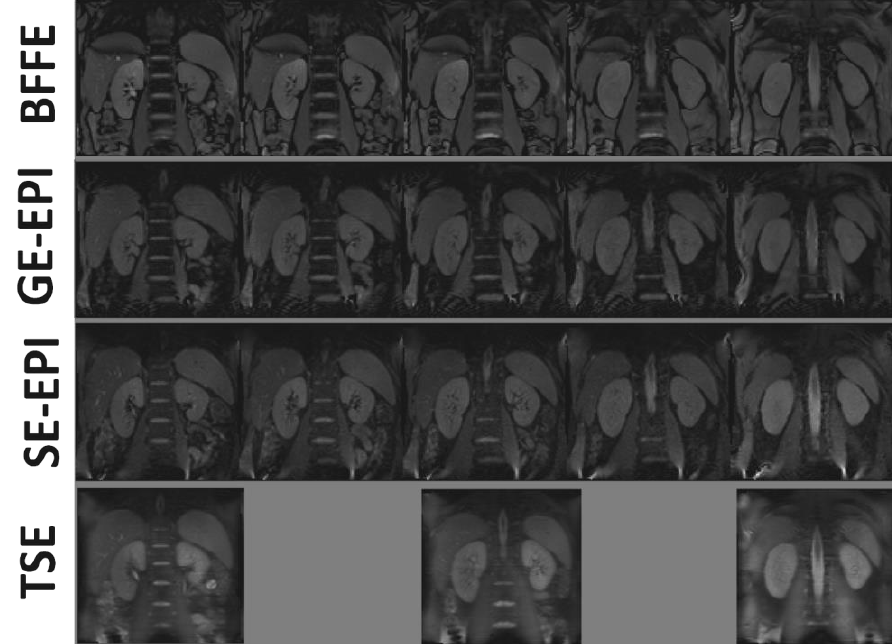
Figure 2. Example base magnetization (M 0 ) images for the balanced fast field echo (bFFE), gradient-echo echo-planar imaging (GE-EPI), spin-echo echo-planar imaging (SE-EPI), and turbo spin-echo (TSE) readout schemes.